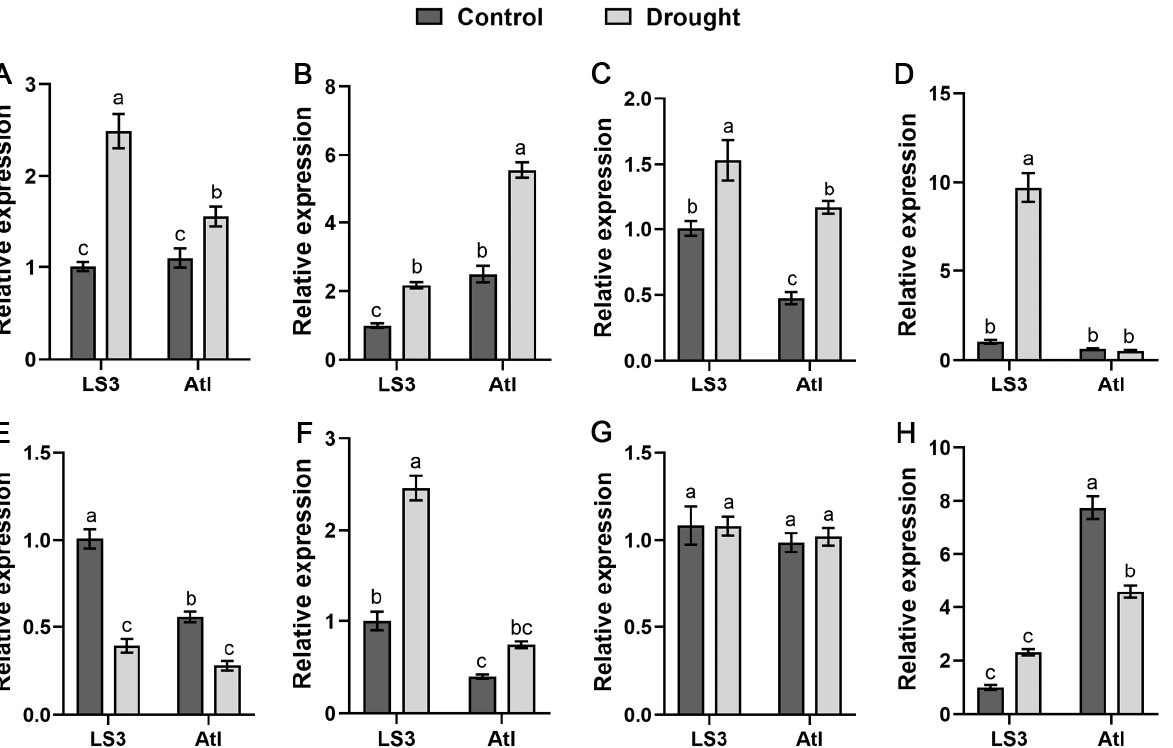
Figure 11. Relative expression level of StSnRK2 genes in different drought-resistant potato cultivars (‘LS3’, drought-tolerant; ‘Atl’, drought-sensitive) under water deficit conditions. Data represent the means ± SD of three replicates, and different letters indicate significant differences at p < 0.05. ( A – H ) StSnRK2.1–StSnRK2.8 , respectively.